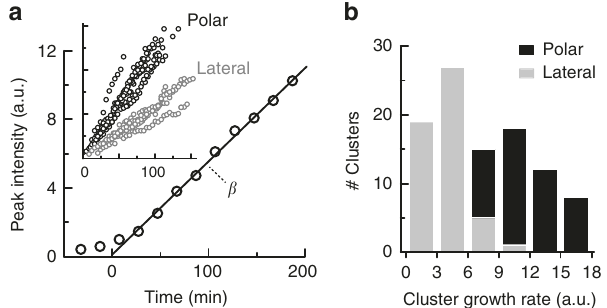
Fig. 3 Initial cluster growth rate. a The main plot presents the growth of a polar cluster, as assessed by following the peak fl uorescence intensity. The ‘ time-zero ’ point was de fi ned by extrapolating from the apparent linear regime to zero intensity (black line). The cluster growth rate ( β ) was de fi ned as the slope of the growth curve at the linear regime. The inset shows additional examples of polar and lateral clusters. b Histogram of the cluster growth rates ( β ) of polar (black) and lateral (gray) clusters (105